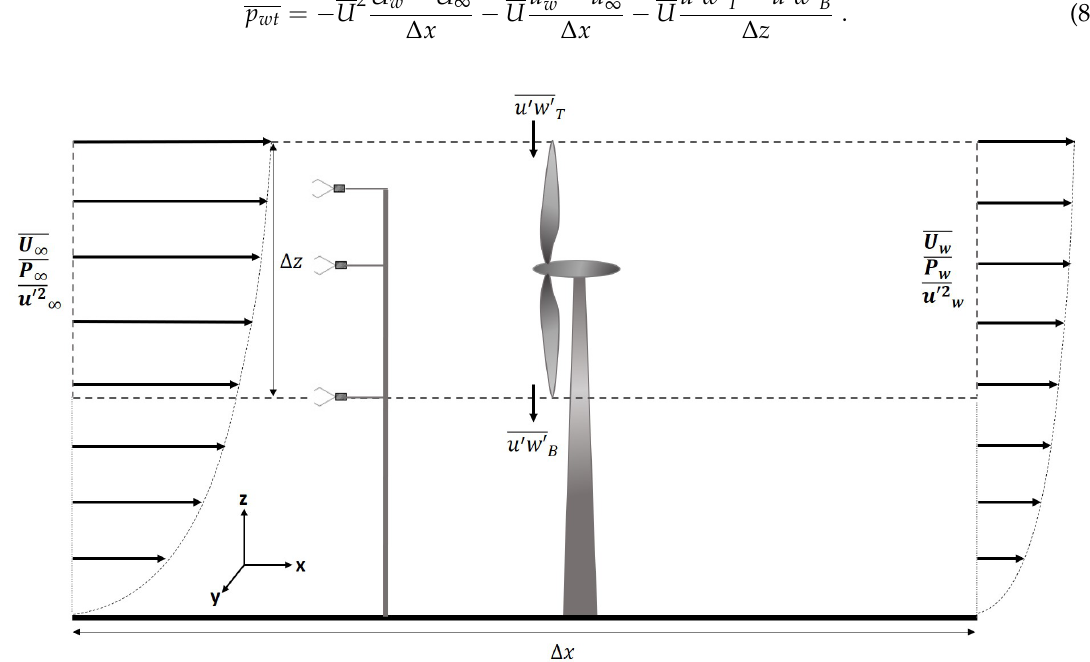
Figure 3. A schematic of the wind turbine, the associated control volume within the ABL, and the variables required in Equation (7). The dashed rectangle depicts the control volume containing the wind turbine